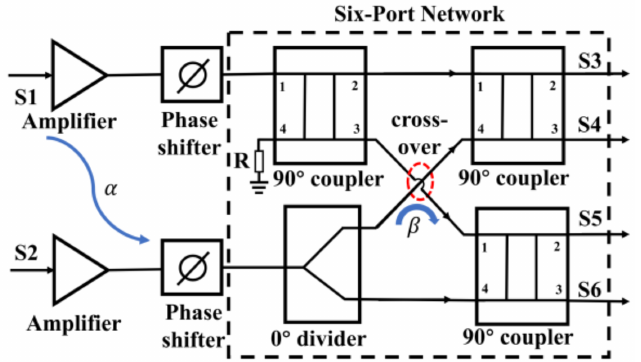
Figure 2. The block diagram of the proposed six-port chip integrated with two amplifiers, two phase shifters, and a six-port circuit.